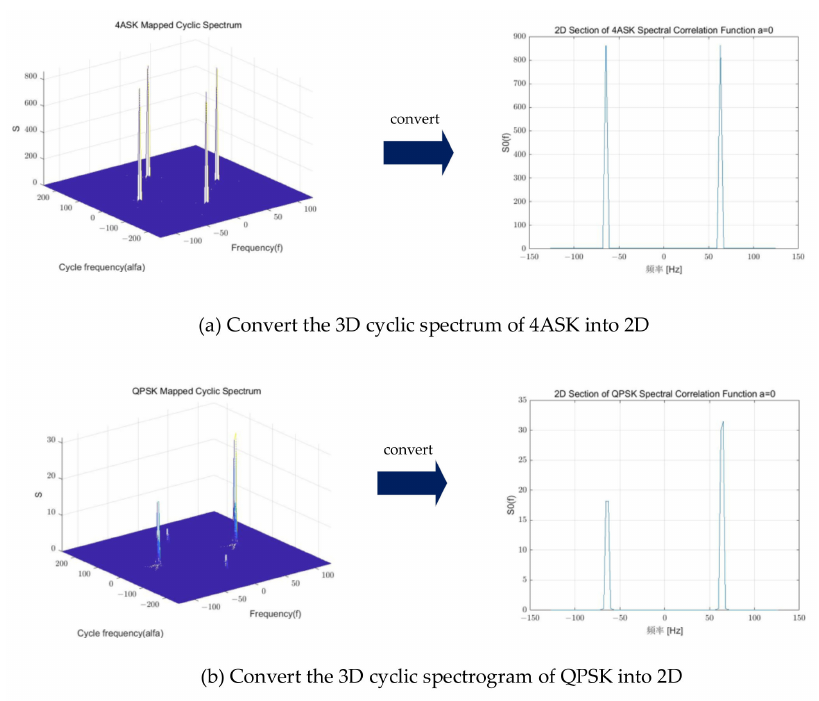
Figure 10. Graphical construction of QPSK and 4ASK